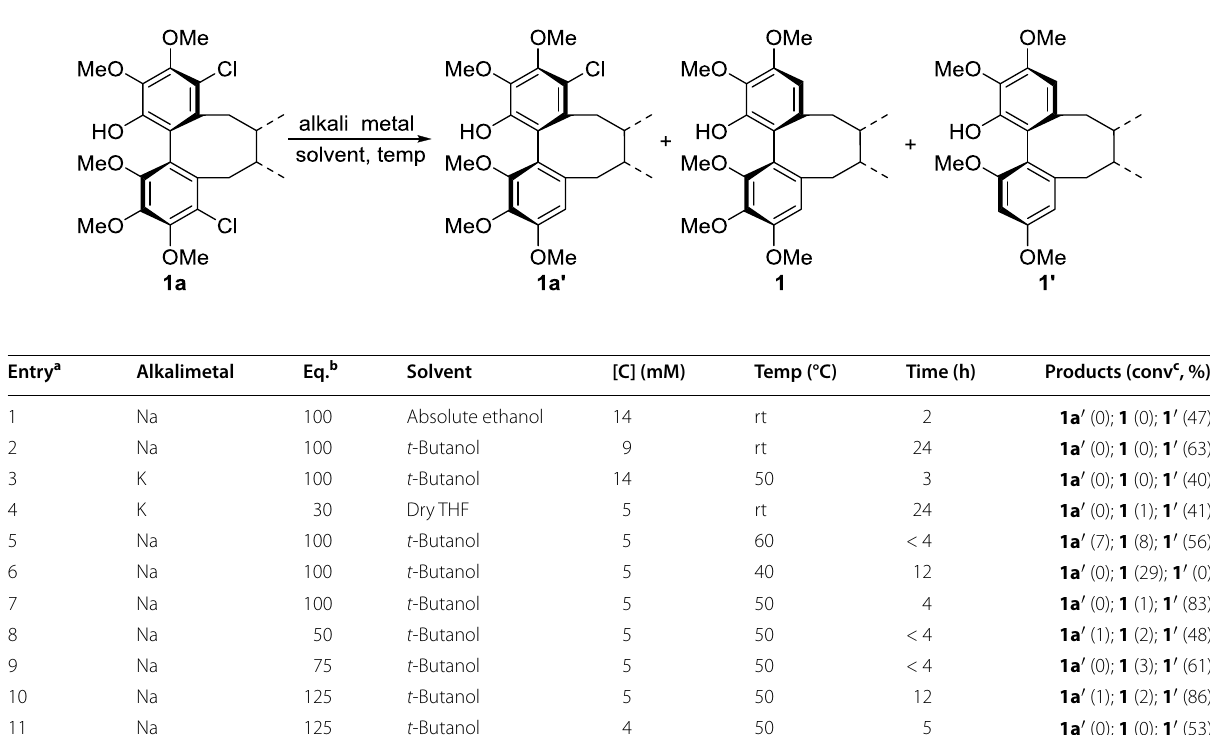
Table 1 Optimization for reaction conditions of dehalogenation and regioselective demethoxylation of 4, 11-dichloro- schisandhenol